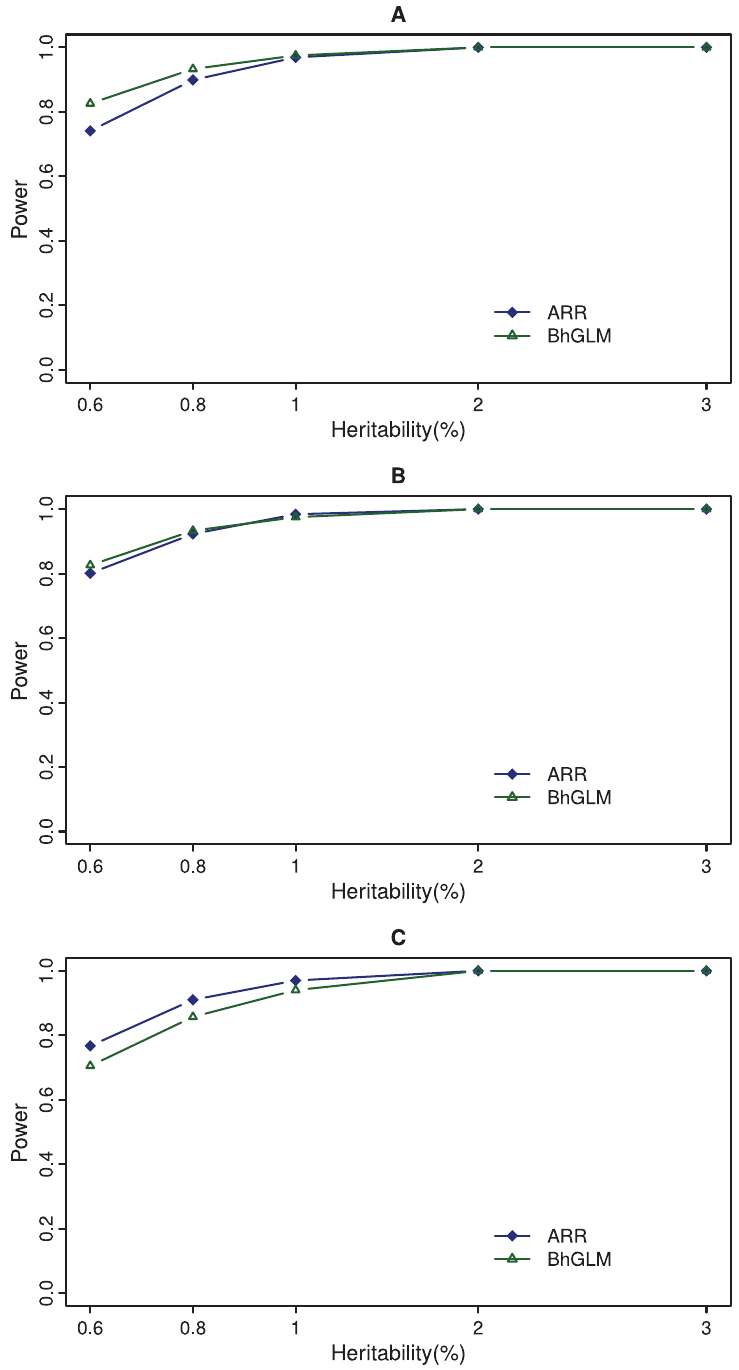
Figure 3. Power comparison between ARR and BhGLM at significance level of 0.05. The top panel (A) gives the powers of the adaptive ridge regression (ARR) and the Bayesian hierarchical generalized linear model (BhGLM) evaluated at the threshold of 3.84. The panel in the middle (B) shows the powers of ARR and BhGLM evaluated at the threshold 2.71 for ARR and 3.84 for BhGLM. The bottom panel (C) shows the powers of ARR and BhGLM using thresholds of 3.45 and 9.78, respectively, to control the 0.05 Type I error